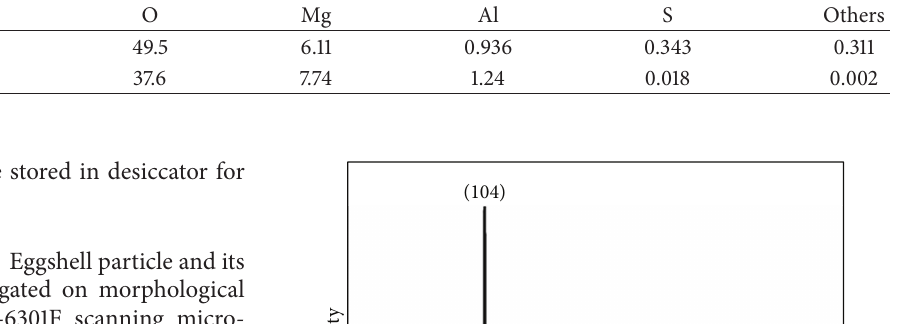
Table 1: Elemental analysis of eggshell.